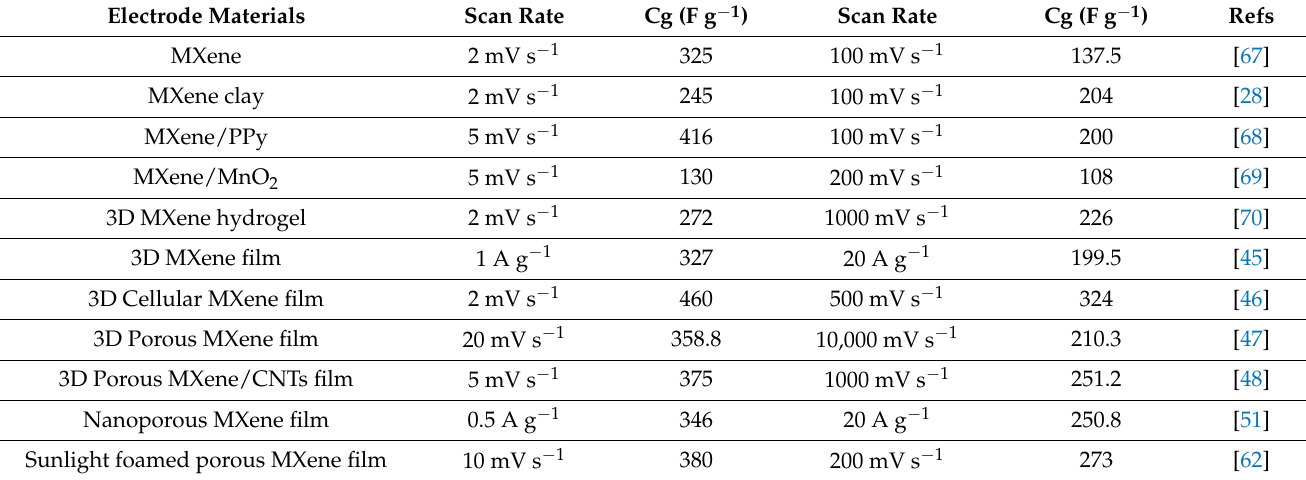
Table 2. Comparison of capacitance for some typical MXene electrodes and 3D porous MXene